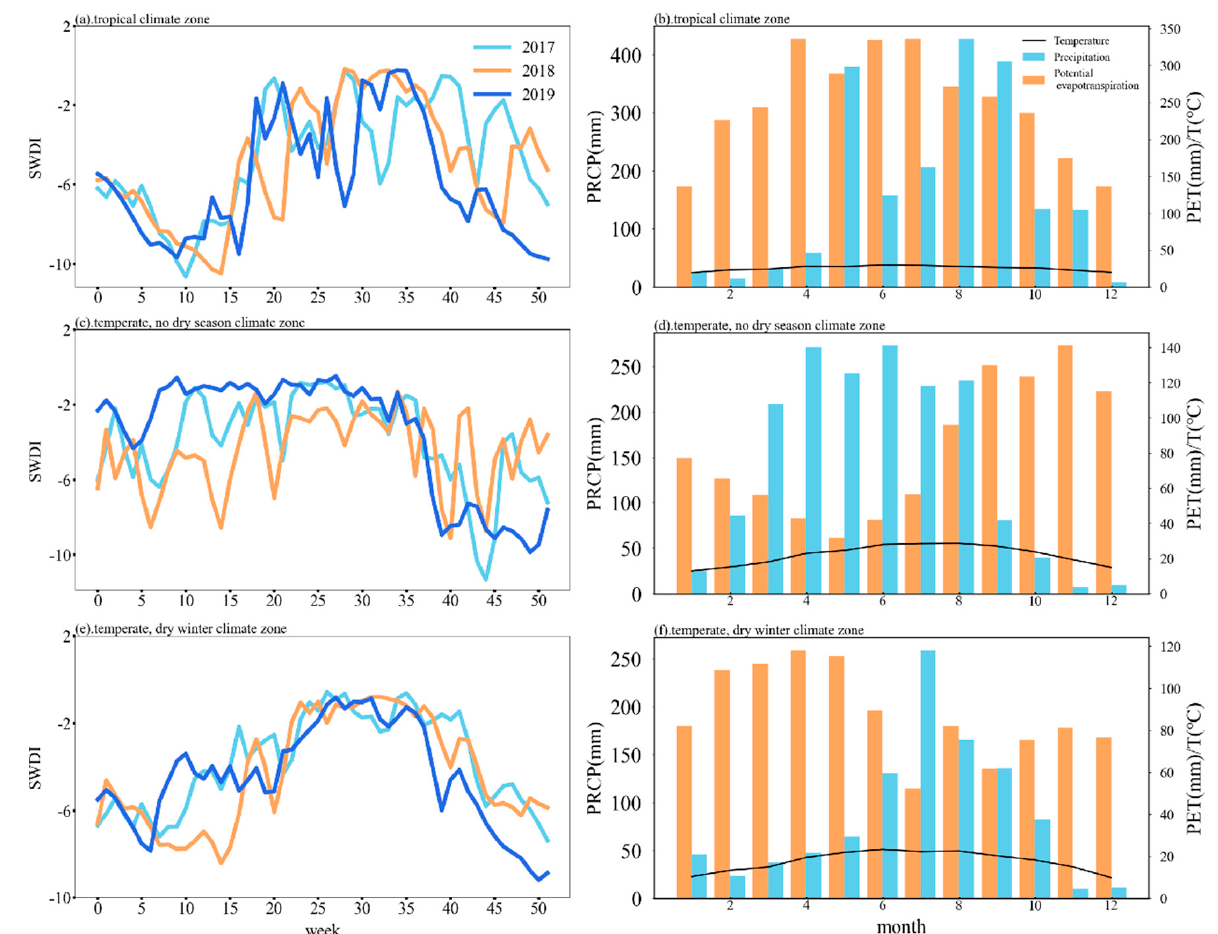
Figure 8. The weekly SWDI (left column) and the monthly temperature (T), precipitation (PRCP), and potential evapotranspiration (PET) (right column) in the tropical climate zone (top row, a , b ), the temperate, no dry season climate zone (middle row, c , d ), and the temperate, dry winter climate zone (bottom row, e , f ) from 2017 to 2019.